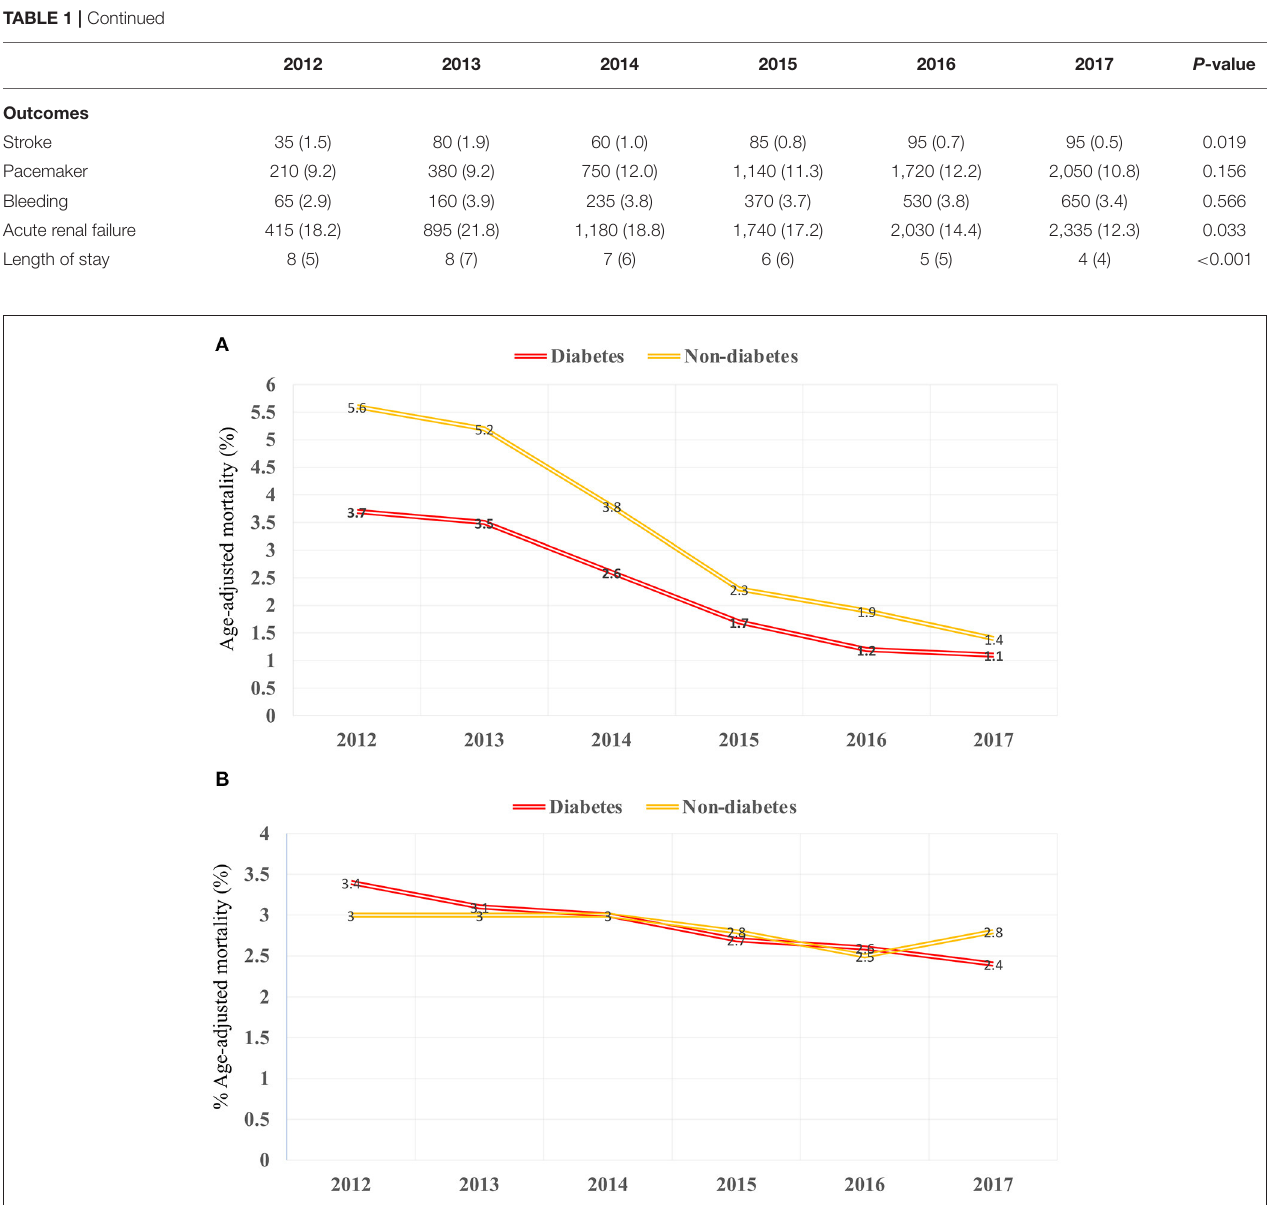
FIGURE 3 | Temporal trend in mortality from 2012 to 2017 in (A) TAVR and (B) sAVR patients.